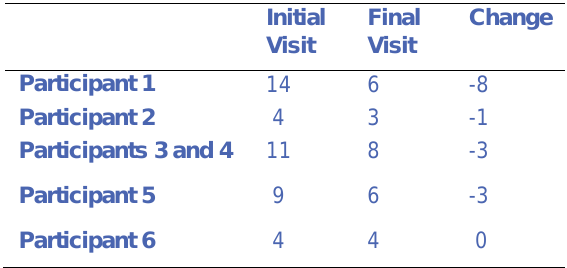
Table 1. SAFER-HOME, v. 3